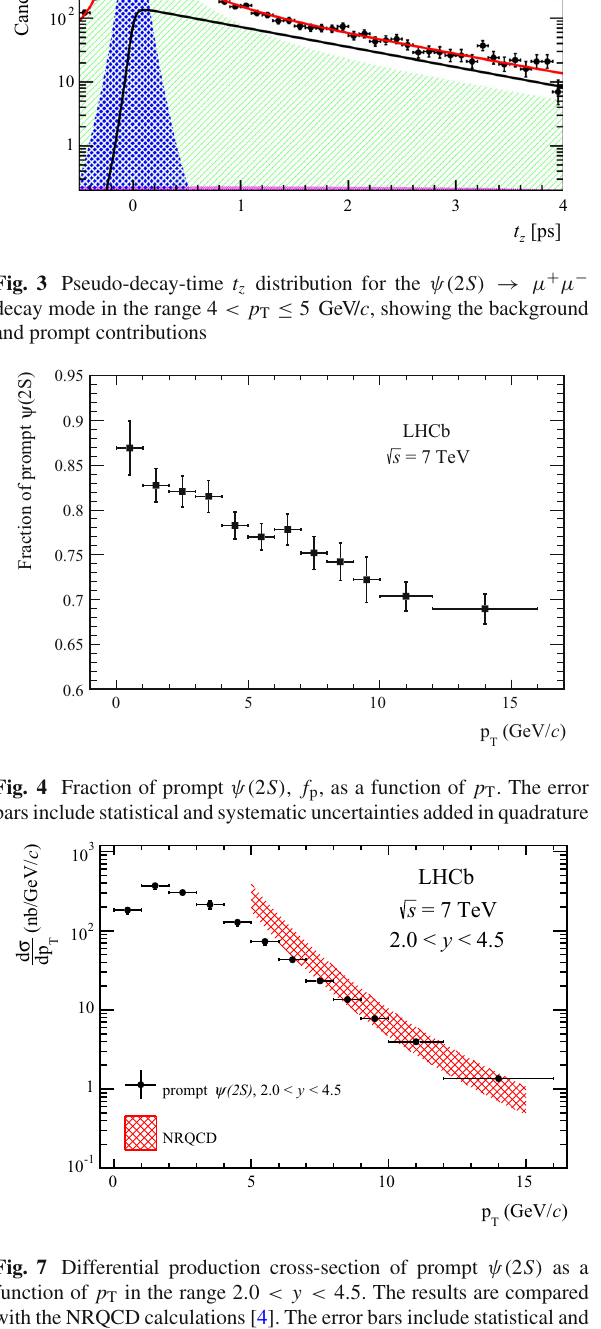
An independent reimplementation of the analysis finds con- sistently lower values of f p . This change in f p is associated with a change in the mean value of t z seen for the from- b component: values of approximately 1 . 1ps were found